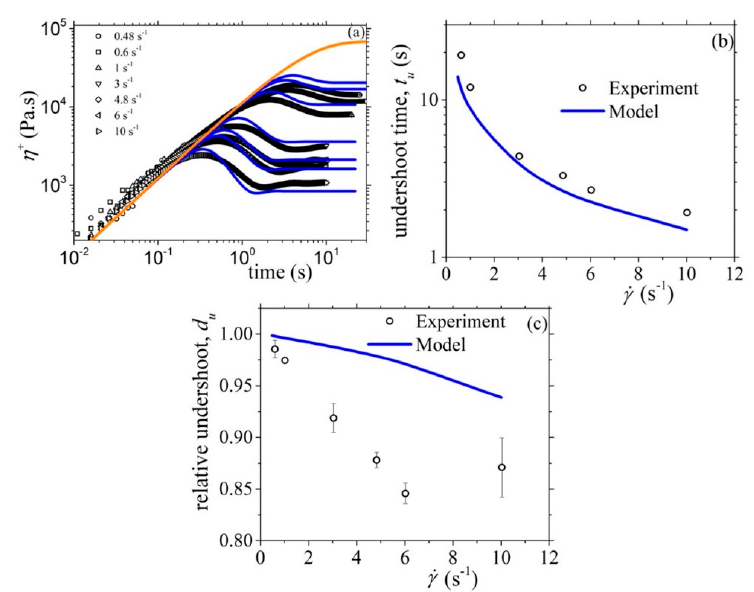
Figure 7. Comparison of the model predictions with the experimental data considered in Ref. [17] for: ( a ) the growth of the shear viscosity, ( b ) the undershoot time, and ( c ) the relative undershoot, upon inception of shear flow. The thick orange line in Figure 7a depicts the LVE envelope, Equation (15a). Same parameter values as in Figure 6.